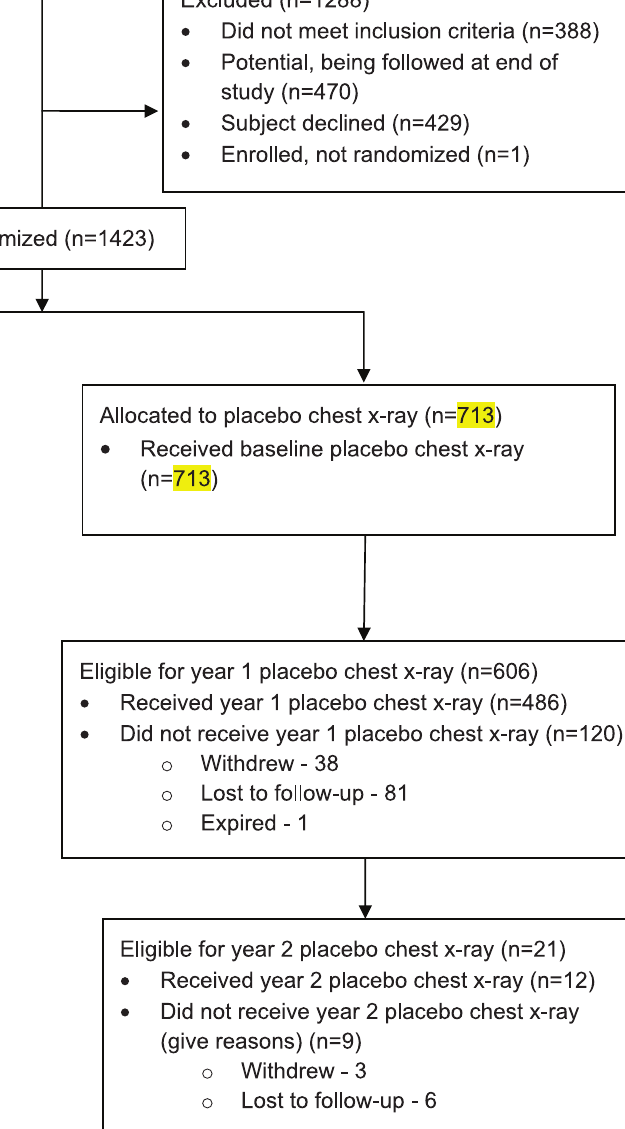
Figure 1. Flow of study subjects through the trial.